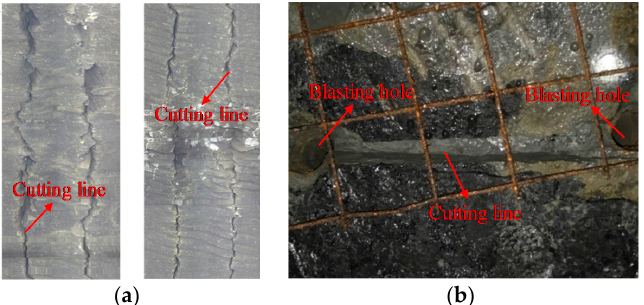
Figure 18. Cumulative blasting effect: ( a ) The cutting plane in the immediate roof; ( b ) the cutting plane on the entry roof surface.